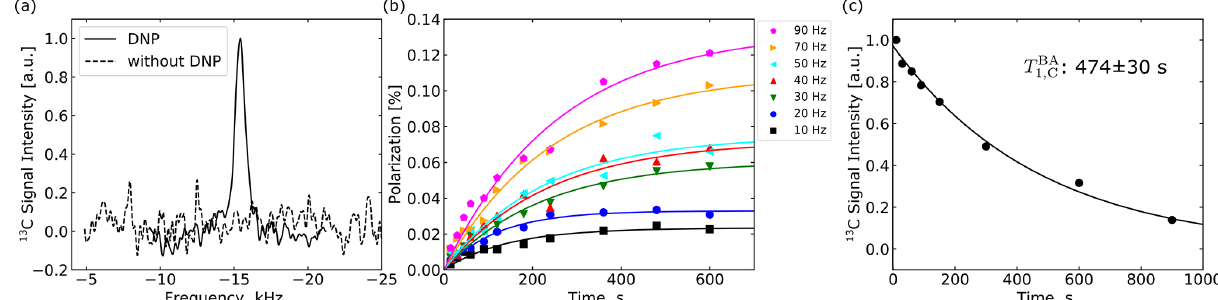
Figure 7. (a) 13 C spectra of PBA with and without DNP. The enhanced spectrum (solid line) was obtained after performing the ISE sequence at a repetition frequency of 90Hz for 600s. (b) Buildup curves of 13 C polarization in PBA for ISE repetition rates ranging from 10 to 90Hz. Each data point represents the 13 C polarization derived from the intensity of the NMR signal accumulated over 16 times. (c) Dependence of the 13 C magnetization in PBA on the time interval between DNP and NMR measurement.